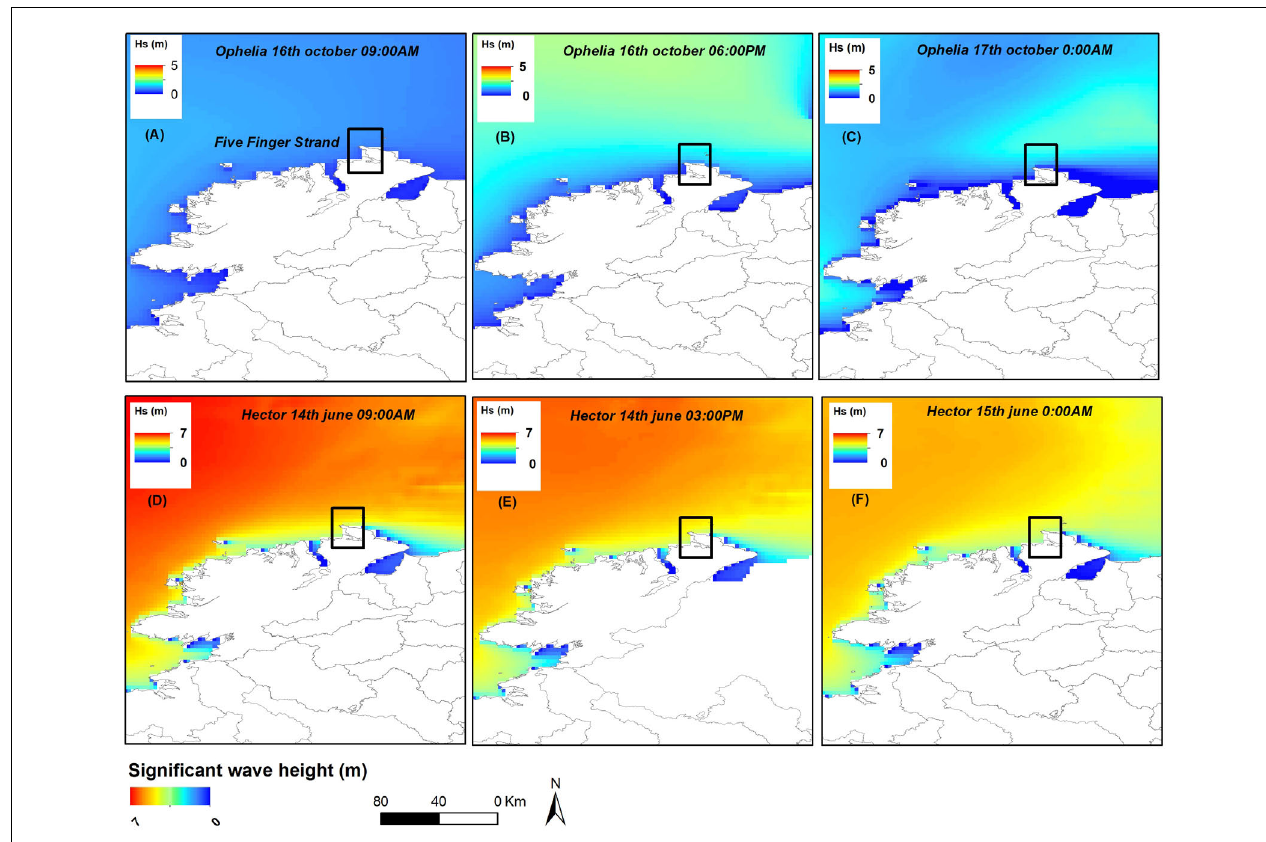
FIGURE 3 | Spatial and temporal evolution of Storm Ophelia (A–C) and Storm Hector (D–F) as they moved across the northwest coast of Ireland. Location map highlights the study site (black square) and hydrodynamic conditions (Significant wave heights) from the Marine Institute East Atlantic SWAN wave